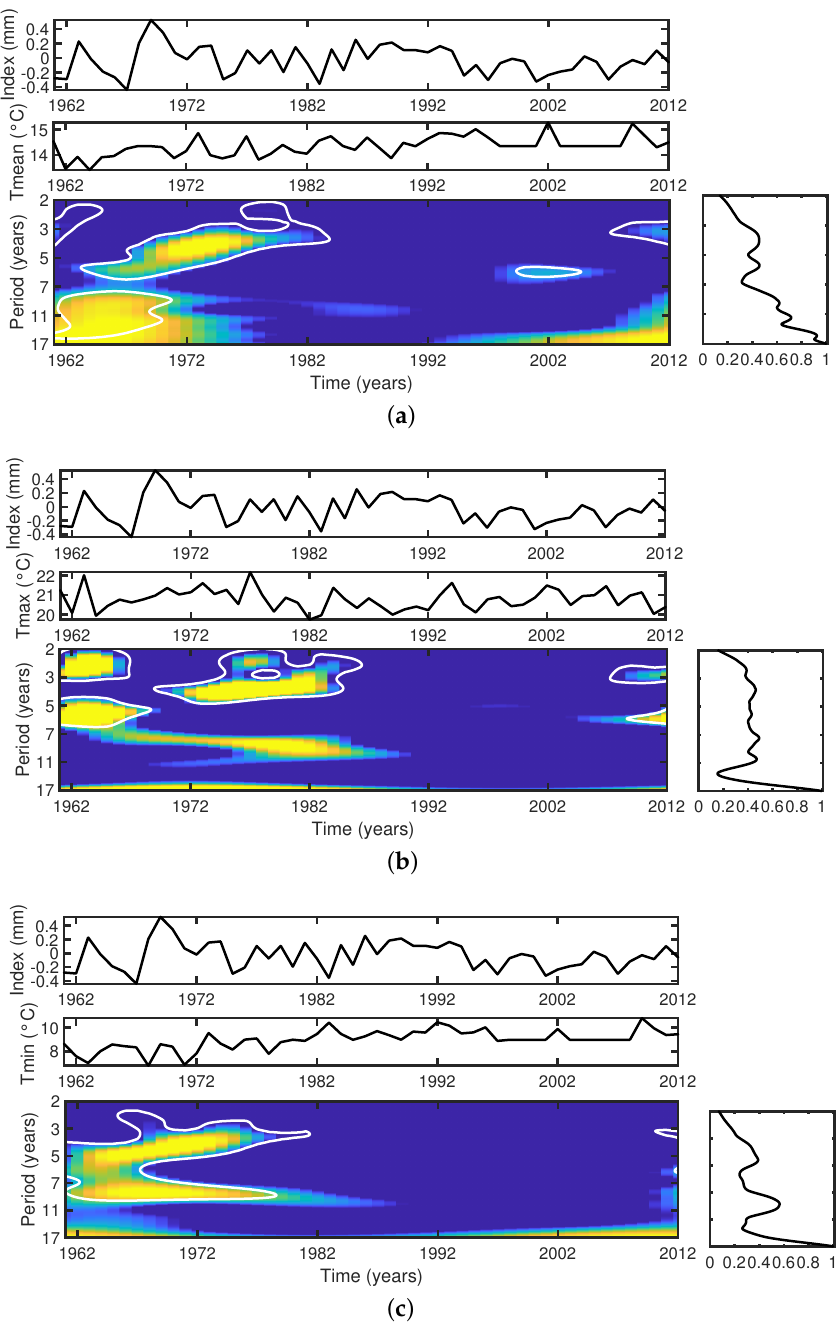
Figure 9. Cross-wavelets between the average growth rings dendrochronological series and mean March temperature ( a ), with maximum March temperature ( b ) and with minimum March tempera- ture ( c ) time-series, respectively, with the global spectrum ( bottom right panel ) and the confidence level of 95% (white